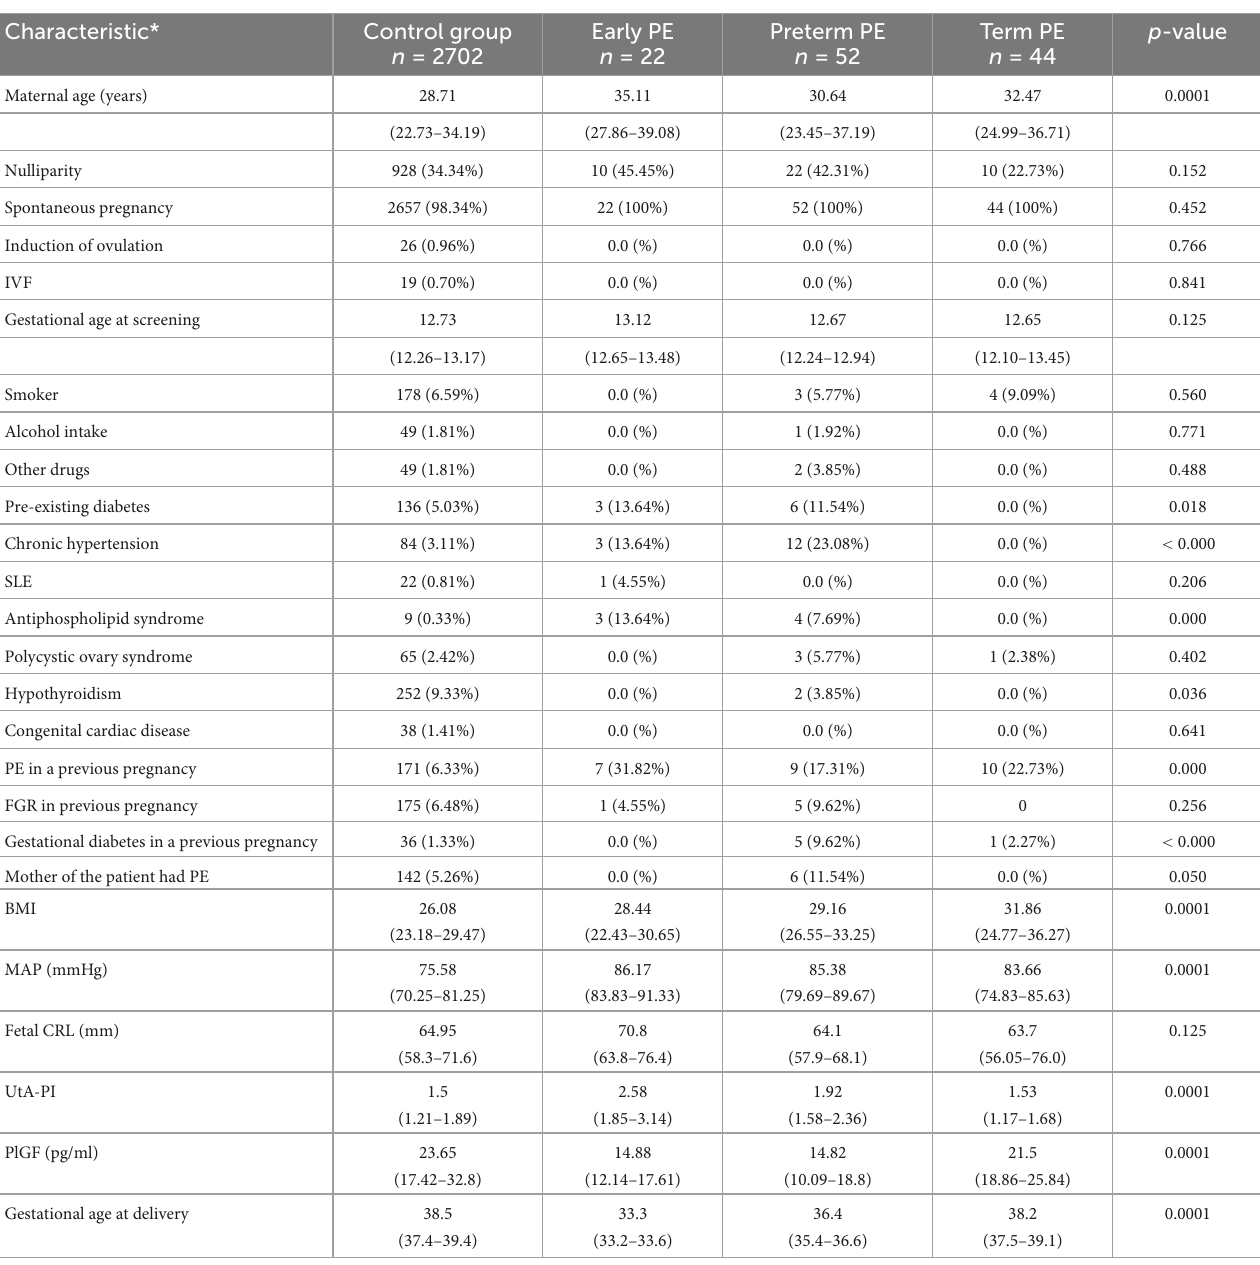
TABLE 1 Characteristics of the included